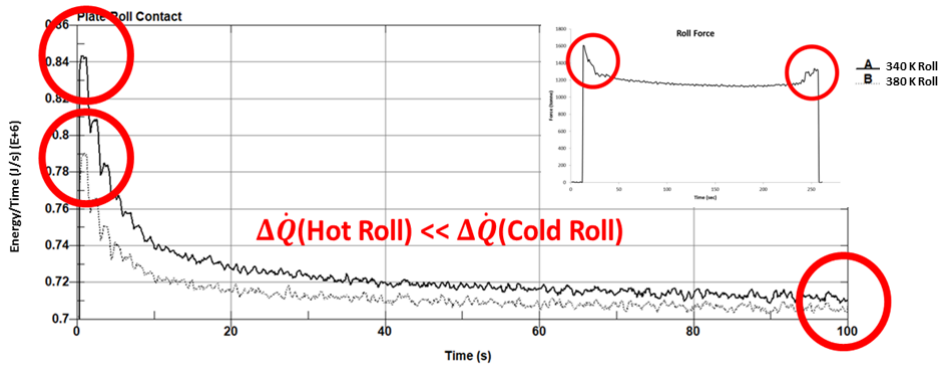
Figure 11. Comparison of heat dissipation from the strip towards the roll for different initial roll temperatures (340 Κ and 380 Κ).